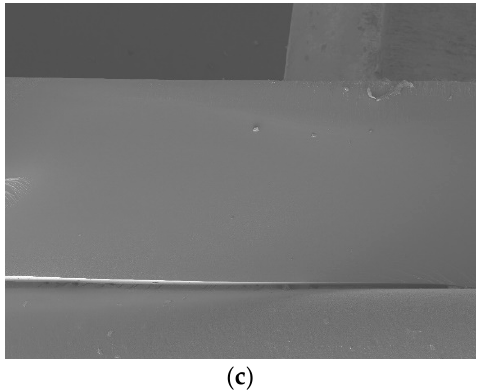
Figure 3. Cross-sectional SEM images of E10 ( a ), T10 ( b ), and P10 ( c ).